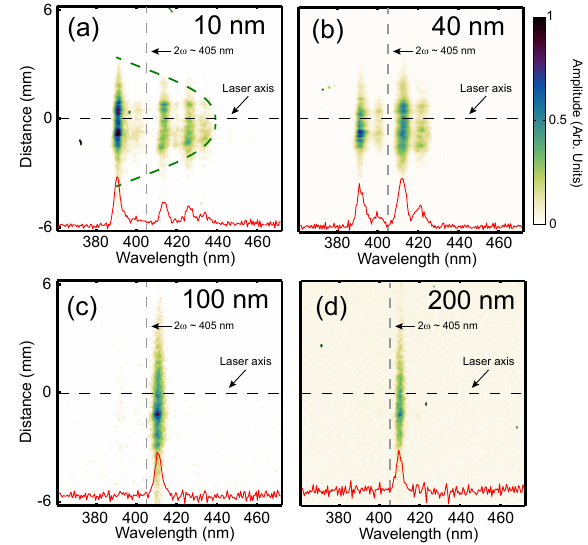
Figure 2. Representative experimental measurements of back-reflected second harmonic light along a radial direction for: ( a ) l = 10 nm; ( b ) l = 40 nm; ( c ) l = 100 nm; ( d ) l = 200 nm targets. The spatial scale refers to the spectrometer plane. The line-outs correspond to the signal sampled along the centre axis. The degree of red and blue shifting of the reflected light, corresponding to the plasma surface receding and expanding towards the laser, respectively, increases with decreasing target